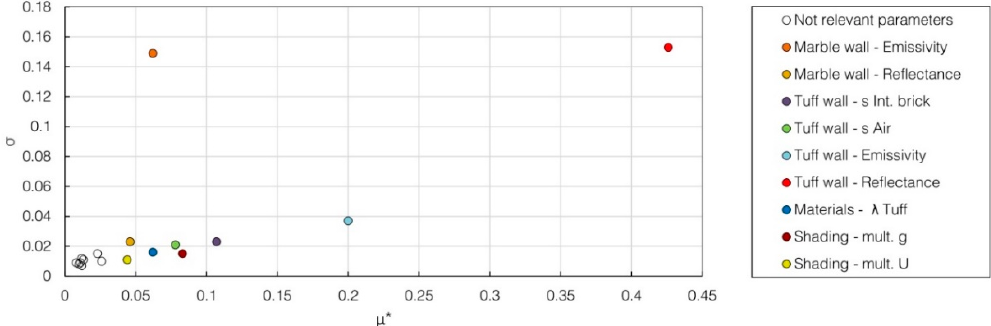
Figure 13. Results for Sensitivity Analysis B. Basement, South exposure.